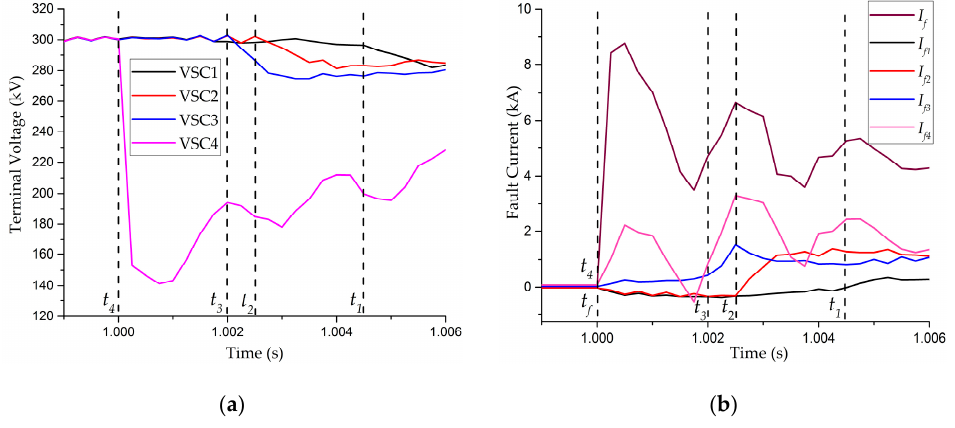
Figure 11. Propagation time delay in MTDC network in case of fault near VSC4. ( a ) Voltage response, ( b ) current response.